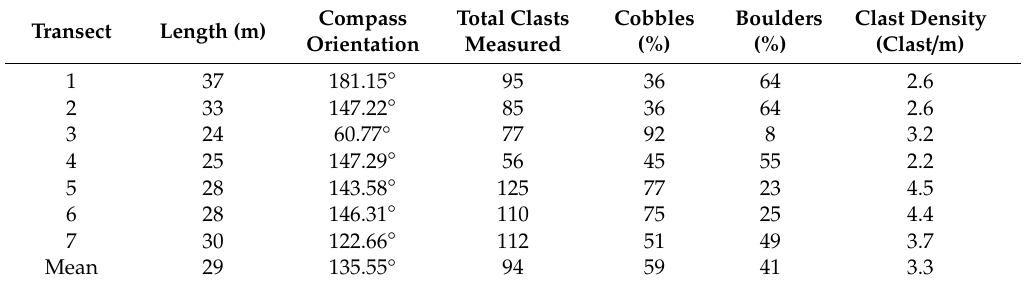
Table 1. Comparative data drawn from transect lines across the bar system at Bah í a San Luis Gonzaga. Transect Length